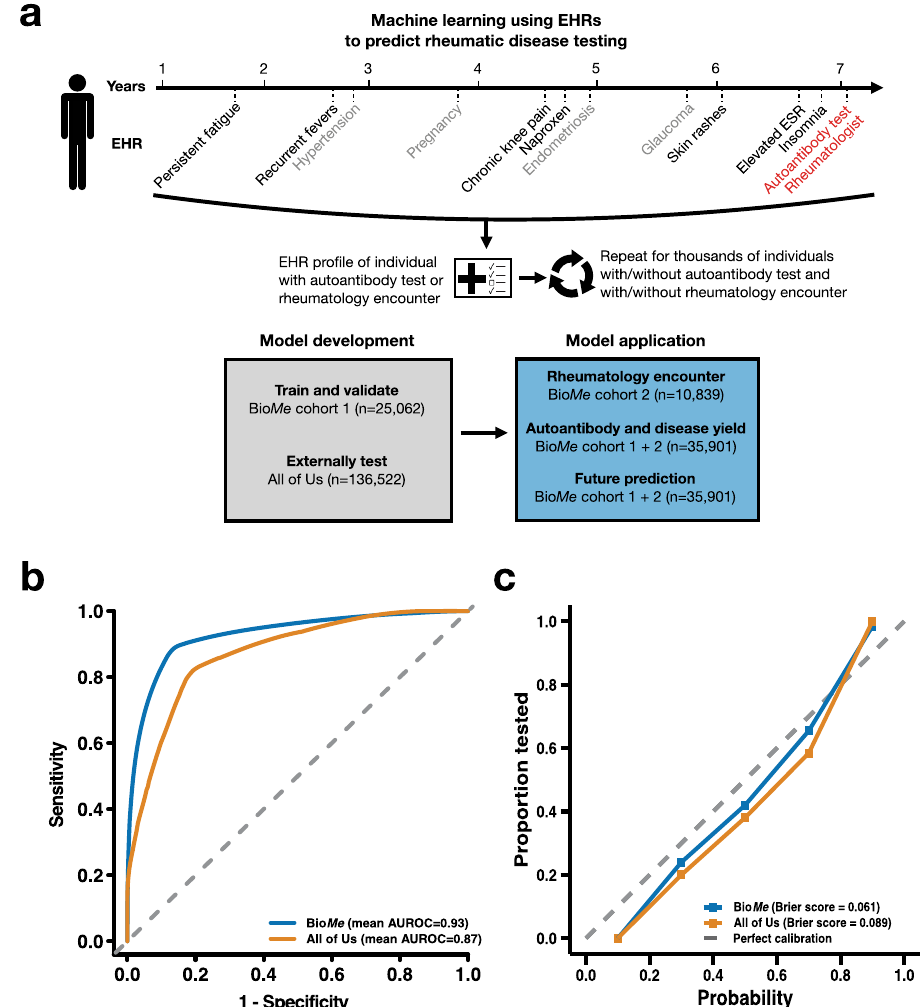
Fig. 1 | Model performance to predict autoantibody testing using electronic health records (EHRs) in validation and external test datasets. a Schematic of studydesigndepictingahypotheticalindividualwhoreceivedautoantibodytesting andhadarheumatologyencounter;EHRdataprecedingthetestorencounterdate